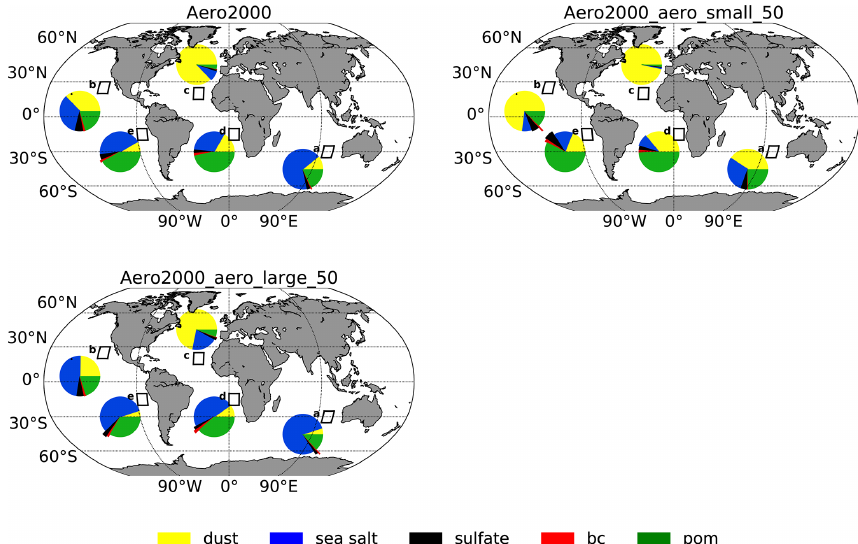
Figure 5. The relative columnar burden contribution of each aerosol type to the total column burden in the simulations Aero2000, Aero2000_aero_large_50, and Aero2000_aero_small_50 in five regions of marine stratocumulus clouds. The boxes indicate the five re- gions of stratocumulus clouds – a: Australian, b: Californian, c: Canarian, d: Namibian, e: Peruvian. A shift in composition can be seen compared to the control simulation